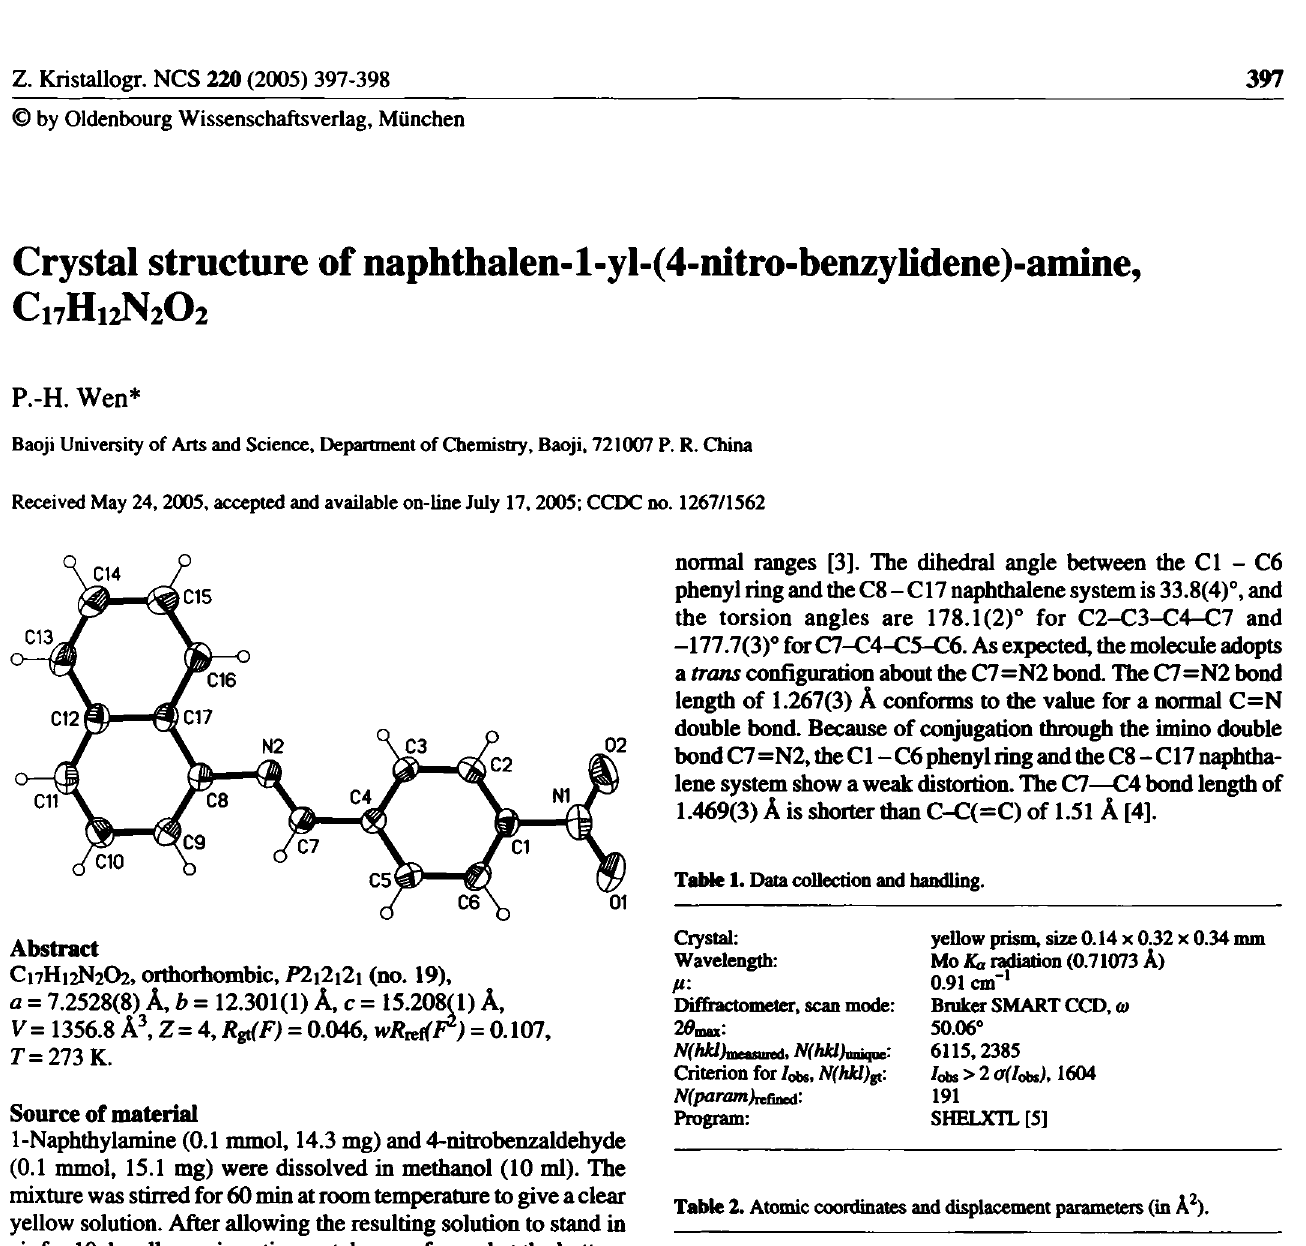
Table 2. Atomic coordinates and displacement parameters (in A 2